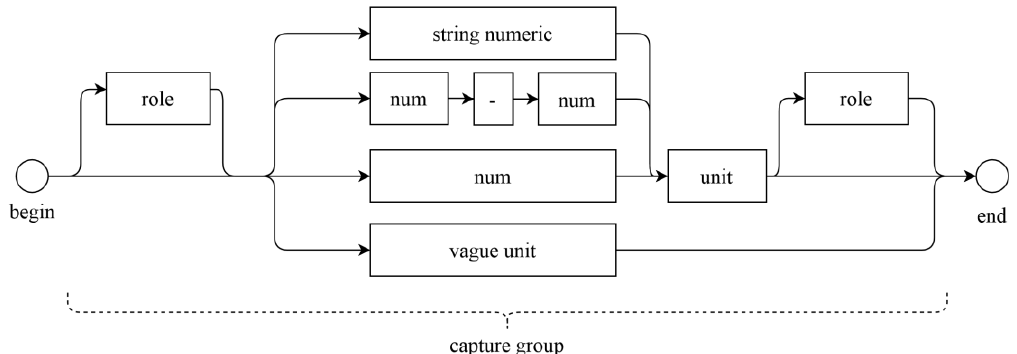
Figure 8. Regular expression to detect numerical argument. The argument typically either started or ended with the role keyword followed by various numerical quantities, followed by the unit of the argument. For example, “the accident left 2 people killed” will be extracted as 2 (numeric) people (unit) killed (role).